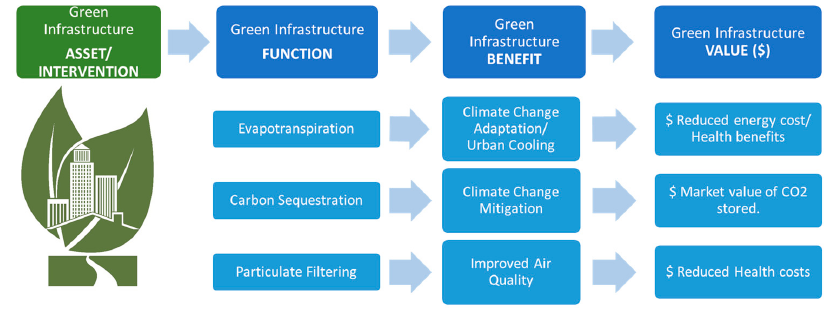
Figure 3. Translating green infrastructure intervention into monetized benefit values. After Ashton et al. 2010 [10].